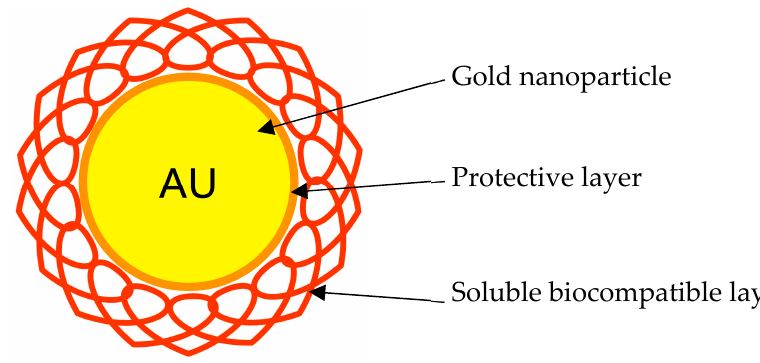
Figure 3. Schematic representation of a gold nanoparticle.